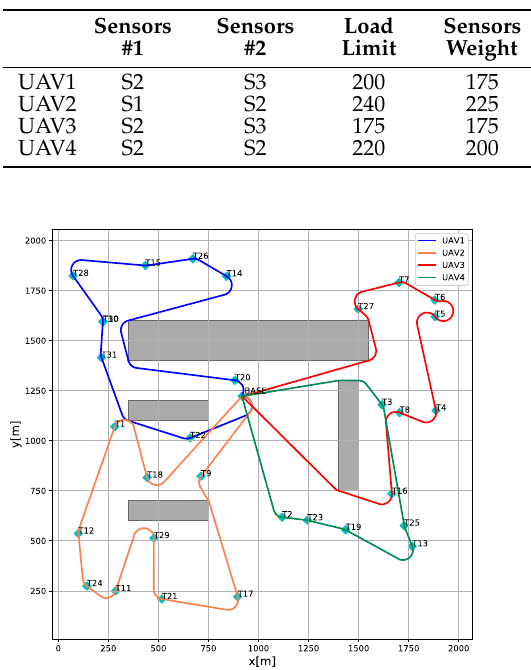
Table 5. Result of sensor allocation.